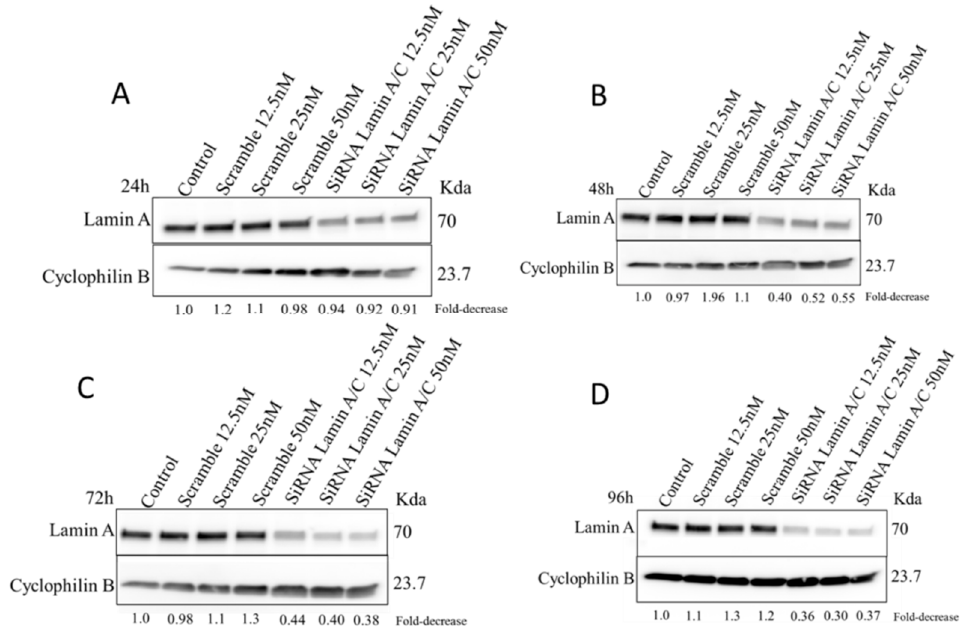
Figure 5. siRNA silencing of lamin A/C in HDLM-2. Lamin A/C expression was monitored by Western Blot after siRNA lamin A/C transfection in different concentration (12.5 nM, 25 nM and 50 nM) for 24 h ( A ), 48 h ( B ), 72 h ( C ) and 96 h ( D ). siRNA Scramble was used as a negative control